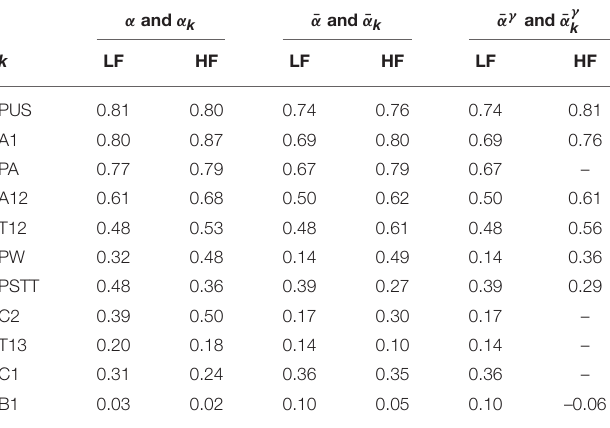
TABLE 1 | Inter-subject Spearman correlations of α { LF,HF } and α { LF,HF } k obtained in the different stages of the protocol.